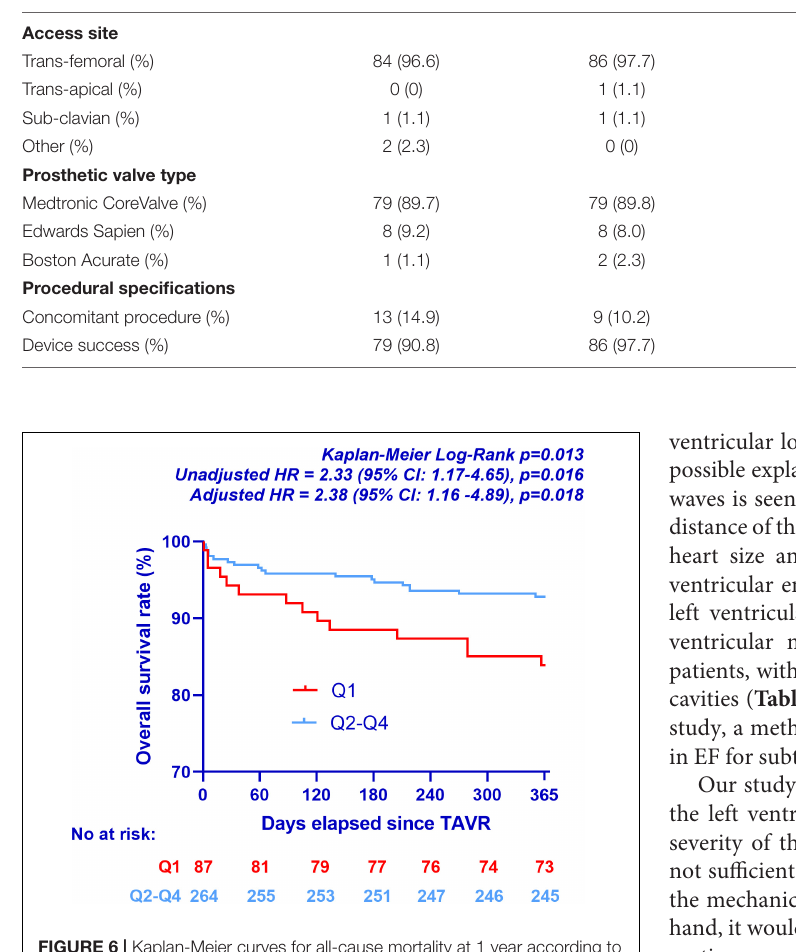
FIGURE 6 | Kaplan-Meier curves for all-cause mortality at 1 year according to BWTT quartiles. Model A: adjusted HR = 2.38 (95% CI: 1.16–4.89, p = 0.018), covariates: gender and STS Score. Model B: adjusted HR = 2.00 (95% CI: 0.95–4.24, p = 0.064), covariates: gender, STS Score and